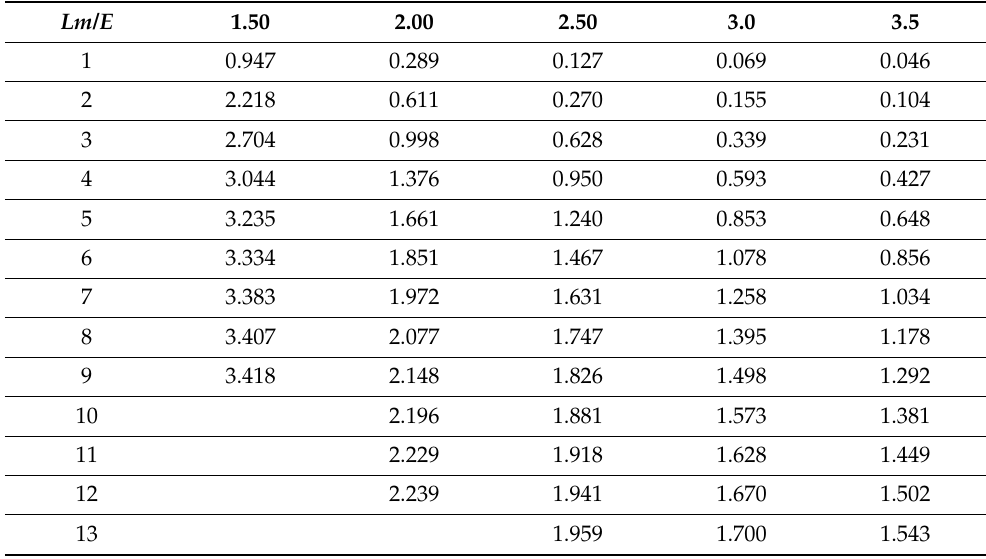
Table 3. Cross sections ( a 2 ) for 1 S to 2 P excitation for various incident energies E (Ry) in the variational 0 polarized